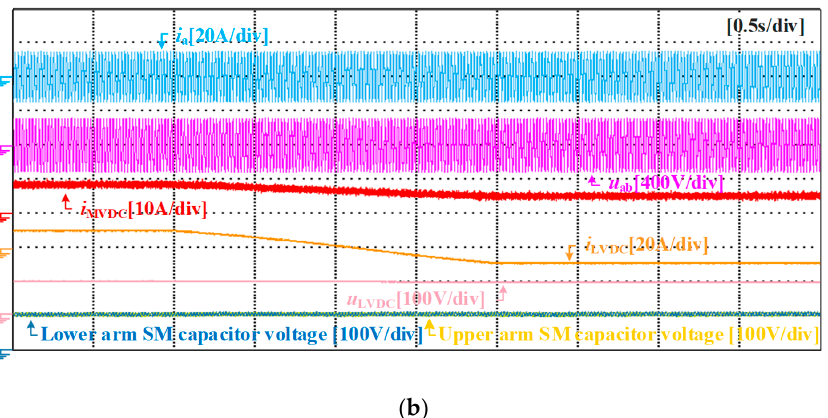
Figure 11. Dynamic experimental results: ( a ) power transfer between the MVAC and MVDC port; ( b ) power transfer between the LVDC and MVDC port.